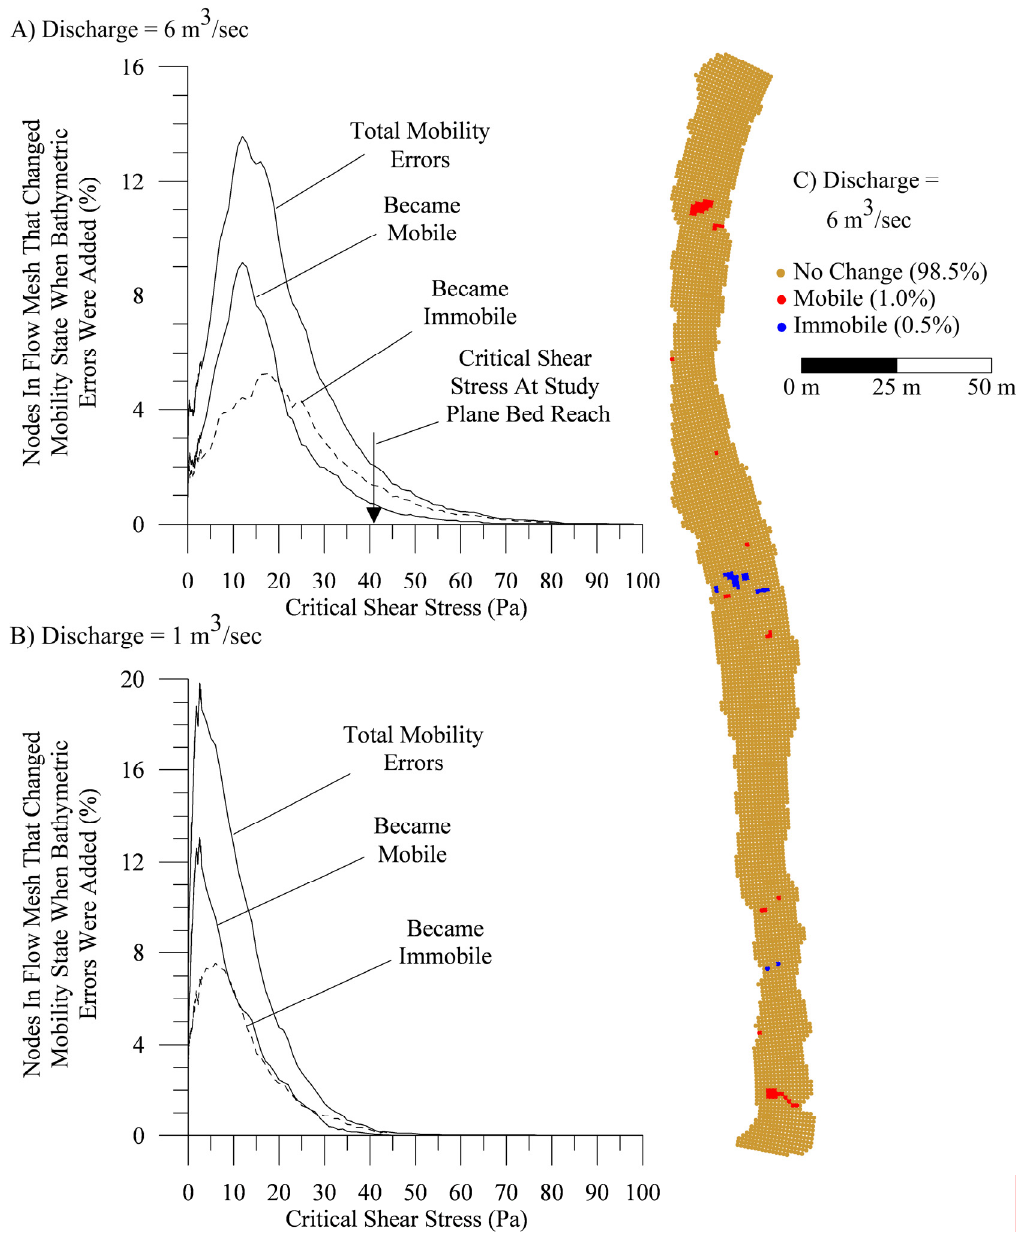
Figure 9. Effects of bathymetric errors on model predictions of bed mobility in a straight, plane bed channel reach. (A) Percent of flow mesh nodes that switched mobility state when flow was the maximum possible inside the channel (6 m 3 /sec); (B) Percent of flow mesh nodes that switched mobility state at low flow conditions (1 m 3 /sec); (C) Spatial distribution of changes in mobility state at high flow and using the critical shear stress for bed mobility of 41 Pa that is applicable for this field site. Brown nodes had no change in predicted mobility, red nodes switched from immobile to mobile and blue nodes switched from mobile to